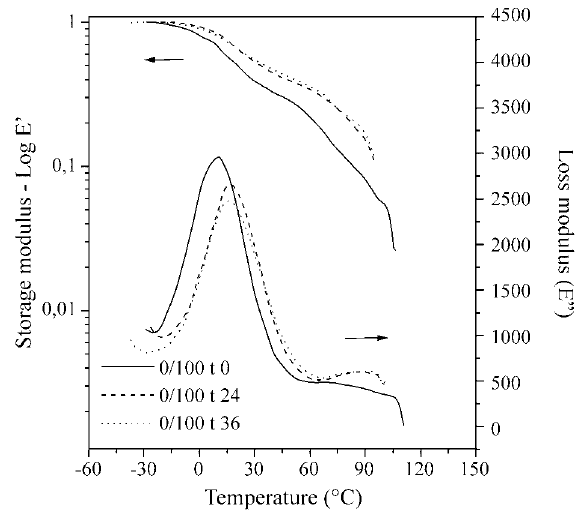
Figure 5. DMA curves for PLLA/PHBV 60/40 blends in relation to degradation periods 0, 2, 4 weeks.